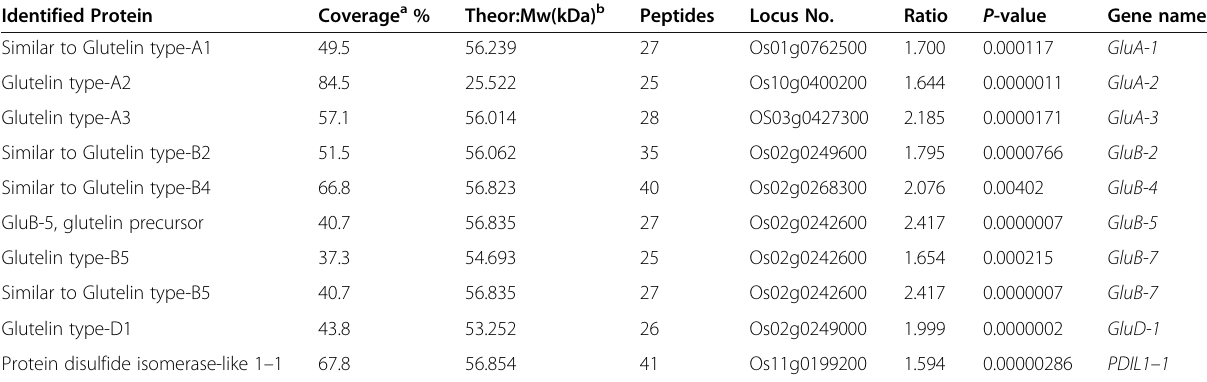
Table 1 Identification of varying expression levels of glutelins and protein disulfide isomerase-like 1 – 1 ( PDIL1 – 1 ) using tandem mass tags ( ≥ 1.5-fold) between 9311-2x and 9311-4x (harvested in 2019) at 25 days after pollination Identified